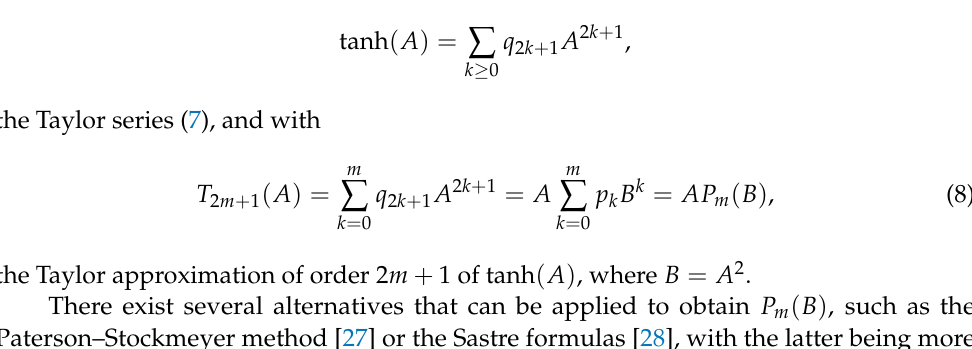
Algorithm 2 works out tanh ( A ) by means of the Taylor approximation of the